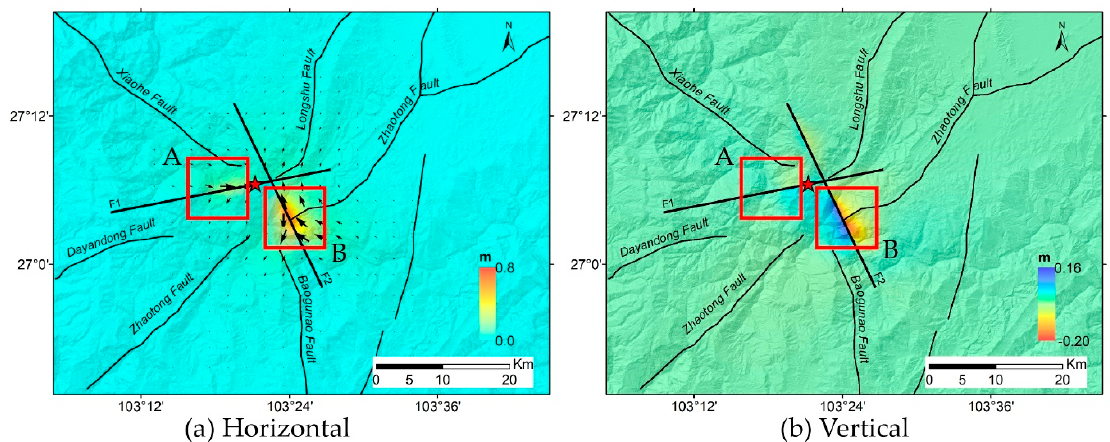
Figure 5. Predicted 3D displacement. ( a ) The horizontal surface displacement. ( b ) The vertical displacement. Regions A and B are the largest surface deformation areas for F1 and F2, respectively.